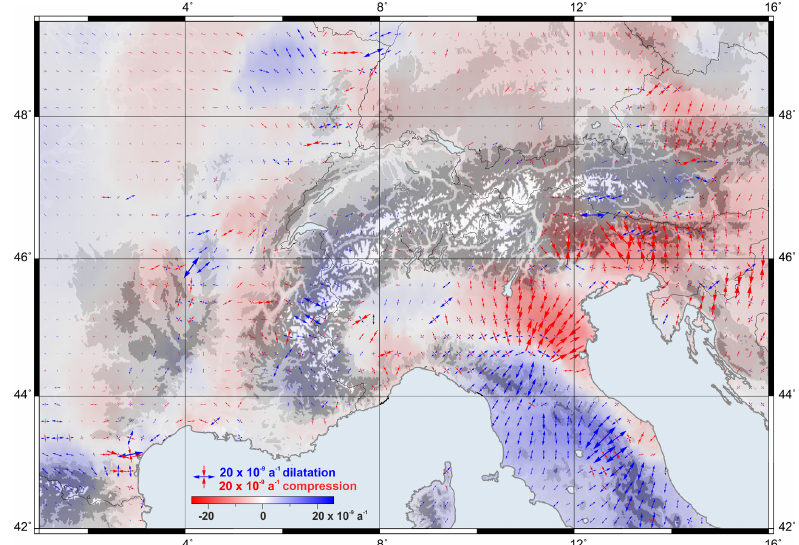
Figure 15. Strain distribution in the Alpine region. Blue shades represent dilatation; red shades represent compression. Topography after the ETOPO1 model (Amante and Eakins, 2009).